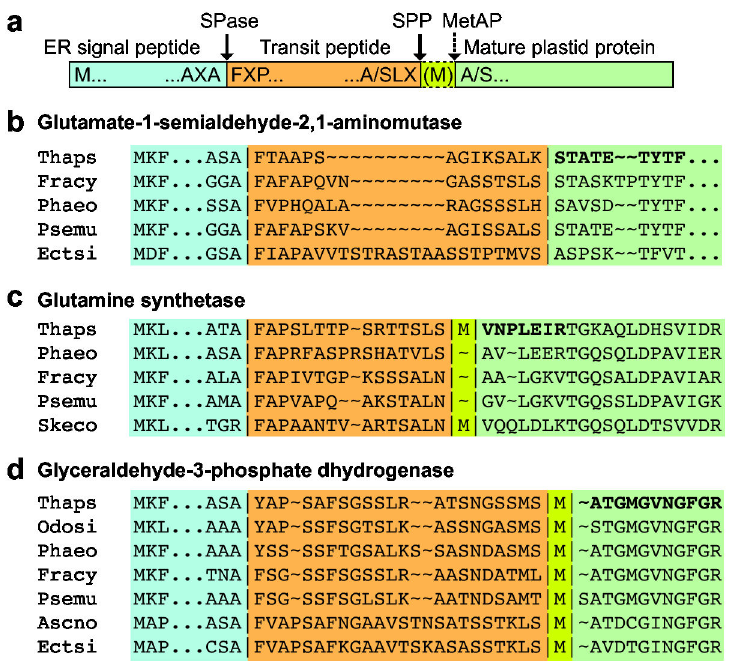
Figure 5. Conserved processing sites in related proteins from other organisms with complex plastids. Processing sites for related proteins of other heterokonts were predicted based on alignments of mature protein sequences. (a) Schematic structure of a nuclear encoded plastid-targeted diatom protein. Proteolytic processing steps and proposed cleavage site consensus sequences are indicated. (b) Alignment of glutamate-1-semialdehyde 2,1-aminomutase from four diatom species and a brown alga (c) Alignment of glutamine synthetase from three diatom and two brown algal species. (d) Alignment of glyceraldehyde-3-phosphate dehydrogenase from five diatoms and two brown algae. Bold letters, mature T. pseudonana N terminal sequences identified in this study. Light blue, SP; orange, TP; yellow, a Met that may be removed from the N terminus after SPP processing; green, mature plastid stroma-targeted protein. Thaps, Thalassiosira pseudonana ; Phaeo, Phaeodactylum tricornutum ; Fracy, Fragilariopsis cylindrus ; Psemu, Pseudo-nitzschia multiseries ; Skeco, Skeletonema costatum ; Odosi, Odontella sinensis ; Ascno, Ascophyllum nodosum ; Ectsi, Ectocarpus siliculosis . doi: